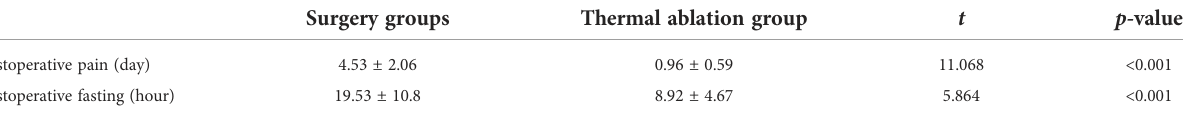
TABLE 5 Comparison of postoperative fasting time and pain time between the two groups ( x ± s